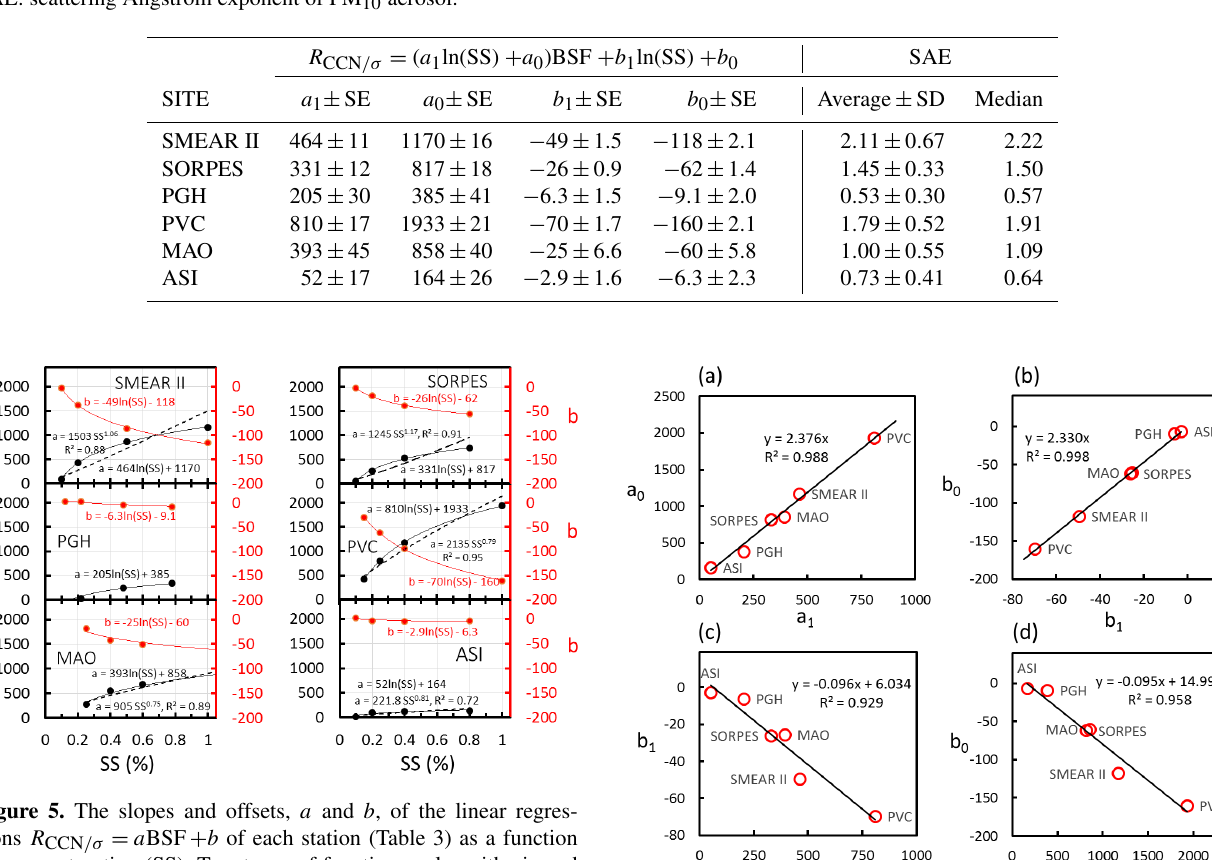
Table 4. The coefficients a 0 , a 1 , b 0 , and b 1 obtained from the fitting of a = a 1 ln(SS) + a 0 and b = b 1 ln(SS) + b 0 with the data in Table 3. The coefficients are written as [ N CCN ] / [ σ sp ] = cm − 3 Mm. SE: standard error of the respective coefficient obtained from the regressions. SAE: scattering Ångström exponent of PM 10 aerosol.